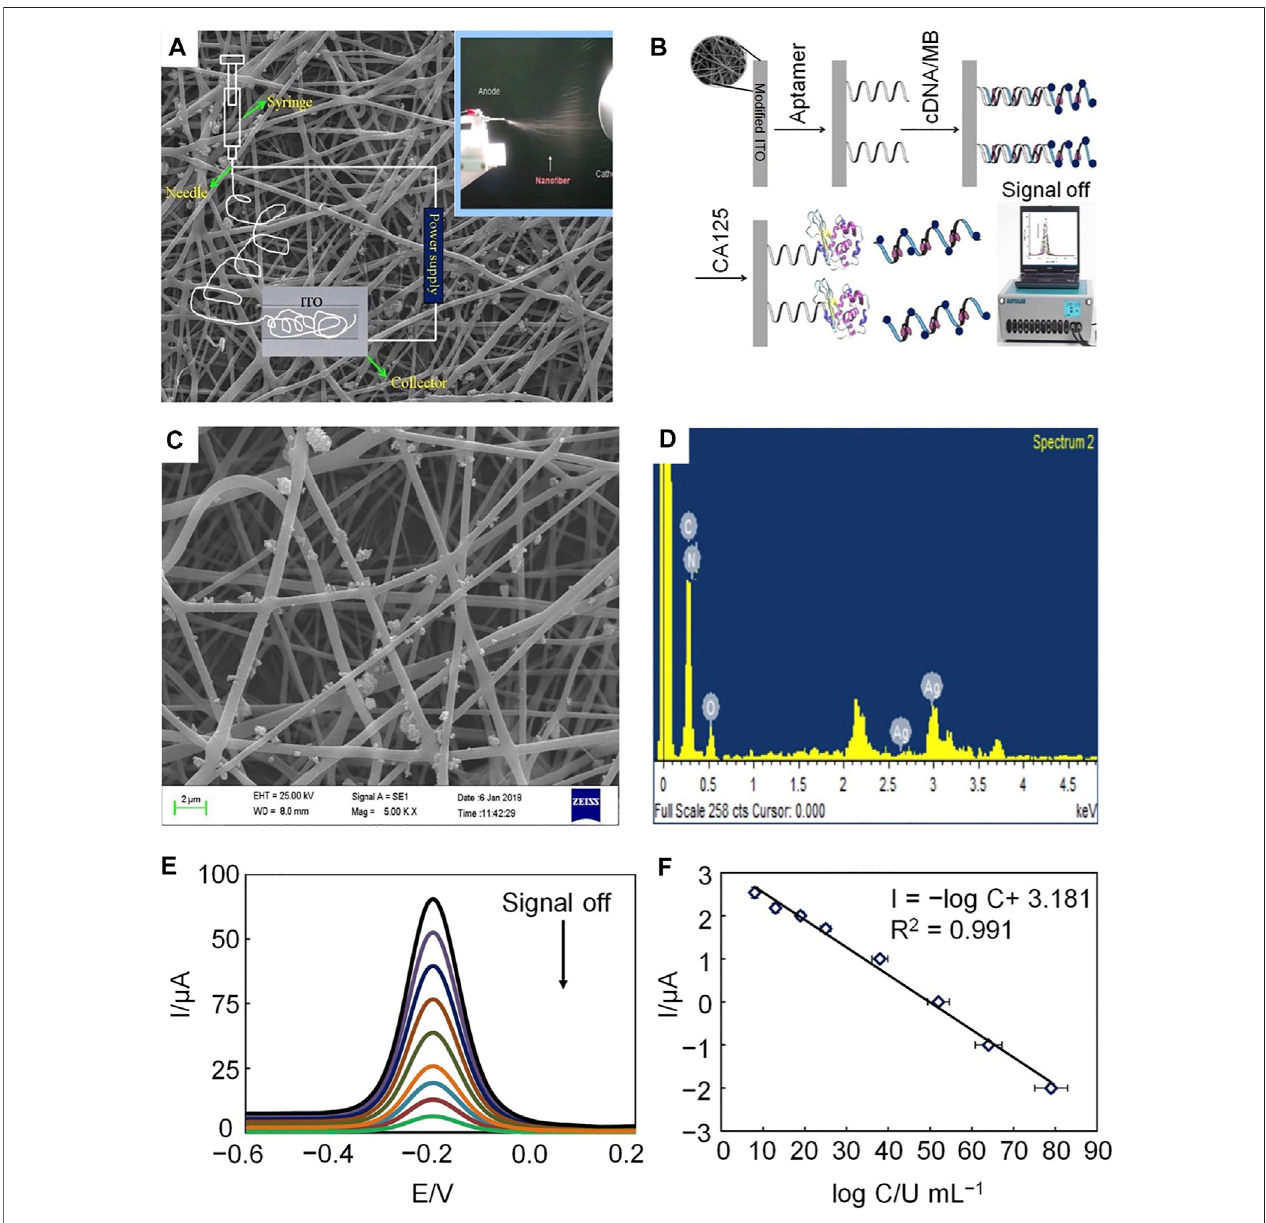
FIGURE 4 | Schematic illustration of electrochemical aptamers used to determine CA125 concentration. (A) The electrospinning setup. (B) Preparation and response mechanism of electrochemical aptasensors. (C) SEM image of AgNP-doped electrospun PAN-oxime nano fi bers. (D) EDX spectrum of AgNP-doped electrospun PAN-oxime nano fi bers. (E) Potential-based current responses of the electrochemical aptamer. (F) Calibration curve of the electrochemical aptamer.